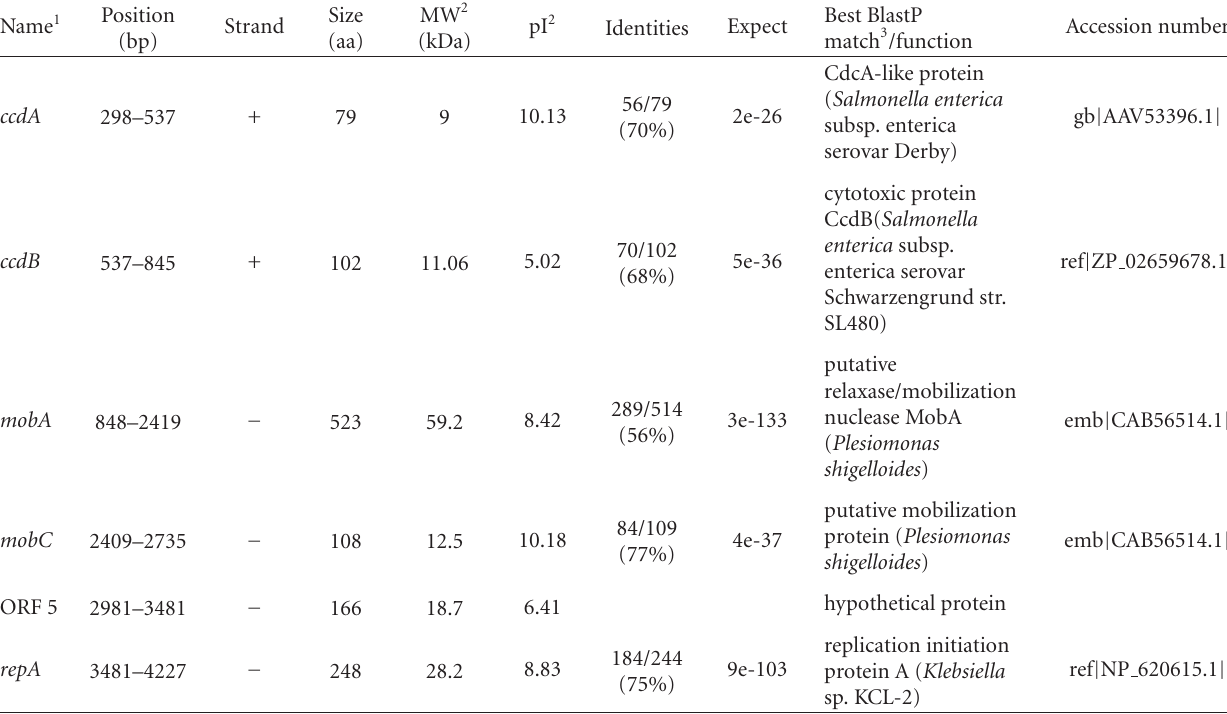
Figure 1: Yersinia enterocolitica biotype 1A strain 07-04449 adhering to eukaryotic cells . Rat intestinal IEC-6 cells (a) and human intestinal Int- 407 cells (b) were infected with strain 07-04449 at a multiplicity of infection (MOI) of 50, stained with Giemsa and subjected to microscopy. Table 1: ORFs identified on plasmid